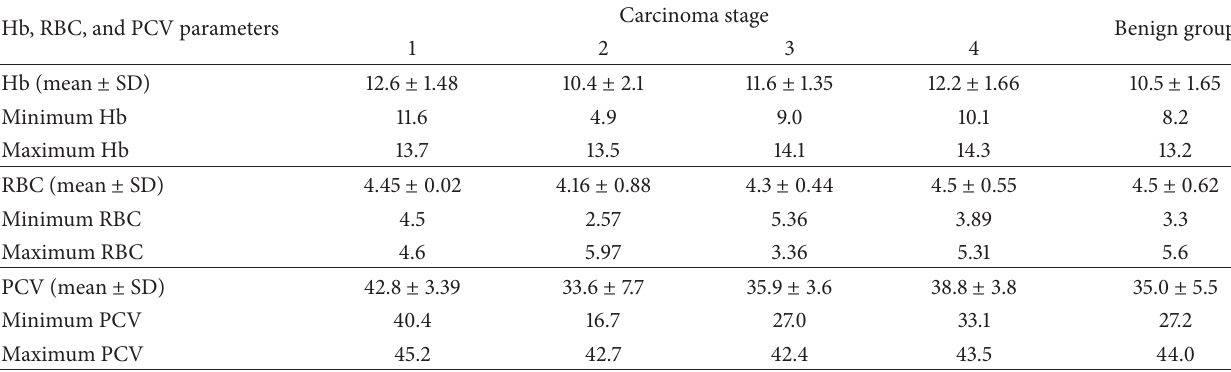
Table 2: Hb, RBC, and PCV parameters in relation to four stages of carcinoma and benign group. Hb, RBC, and PCV